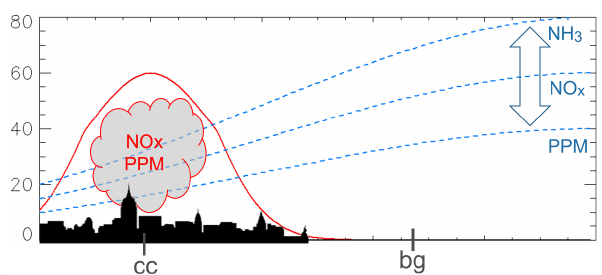
Figure A1. Schematic representation of the theoretical example used to compare the three SA approaches. The city source (in red) emits NO x and PPM. The background (in blue, including other cities as well as rural sources) is composed of NO x , PPM, and NH 3 in different relative proportions (indicated by the arrow). The “cc” and “bg” symbols represent the city centre receptor and the back- ground location used for the increment approach,